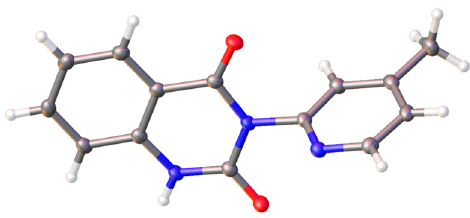
Figure 1. Molecular structure of quinazoline-2,4-dione 3a (Olex2 view).